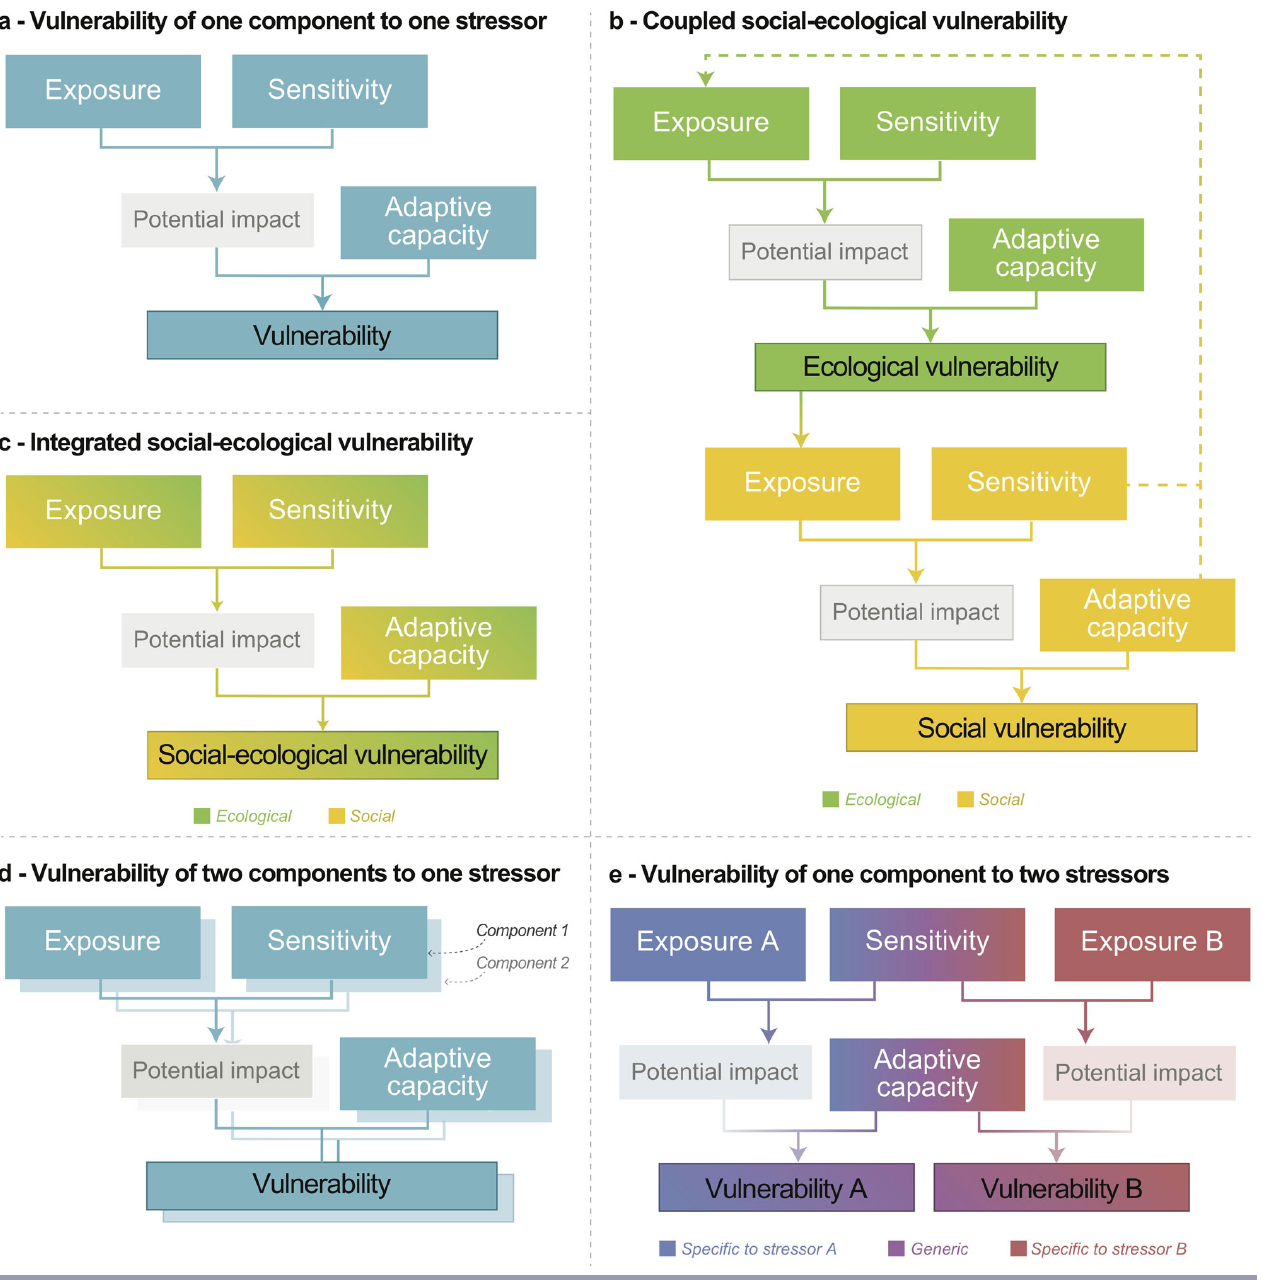
Fig. 3 . Examples of possible structures for the vulnerability assessments, depending on how the system was conceptualized. (a) Default Intergovernmental Panel on Climate Change vulnerability framework. (b) Coupled social-ecological vulnerability framework where ecological vulnerability shapes exposure (i.e., degradation of the ecological system affects the social system), and social sensitivity and adaptive capacity may shape ecological exposure (e.g., high dependence on the ecological system for production leads to high exposure; dashed arrow). (c) Integrated social-ecological vulnerability combining social and ecological indicators within each vulnerability dimension. (d) Vulnerability of two components (e.g., agriculture and fishing sectors) to a single stressor (e.g., climate change). (e) Vulnerability of a single component (e.g., resource-dependent communities) to two stressors (e.g., climate change and